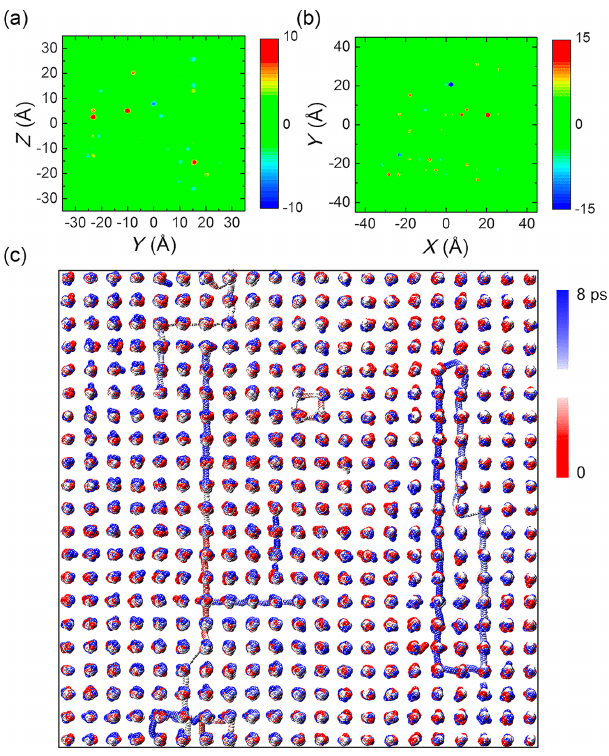
FIG. 4. Behavior of sc Ca at finite temperatures from machine- learning MD simulations at 40 GPa. (a), (b) The atomic flux density of planes perpendicular to the h 100 i at different directions in the picosecond scale from ML MD simulations at 40 GPa and ð y; z Þ in a 20 × 20 × 20 supercell (8000 1300 K. Panel (a) is F x ð x; y Þ in a 25 × 25 × 25 supercell (15 625 atoms) and (b) is F z atoms). The chain-melting behavior along the h 100 i is visible. The positive (red) and negative (blue) values of density represent the diffusion directions of atoms, the green area represents the atoms in solid state. (c) Snapshots of 1D cooperative diffusion state with chains along the h 100 i and rings (the data of 1200 and 1300K were overlapped to show different diffusive behaviors). Chains and rings coexist with solid